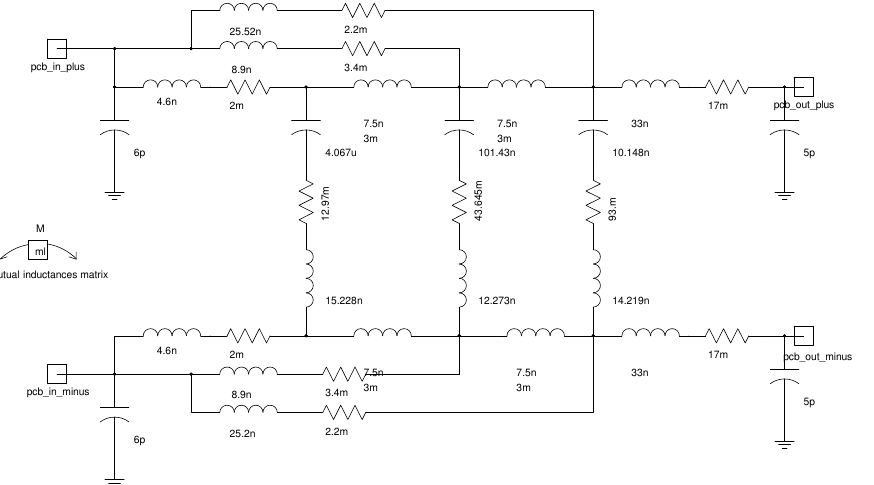
Figure 8. The PCB of the presented buck converter ( a ) view from the top ( b ) geometrical model of PCB.